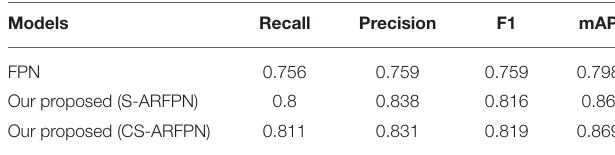
between the predicted value and the true value of our model. The TABLE 3 | The evaluation metrics of the model with/without the attention module. The best results are shown for each model.